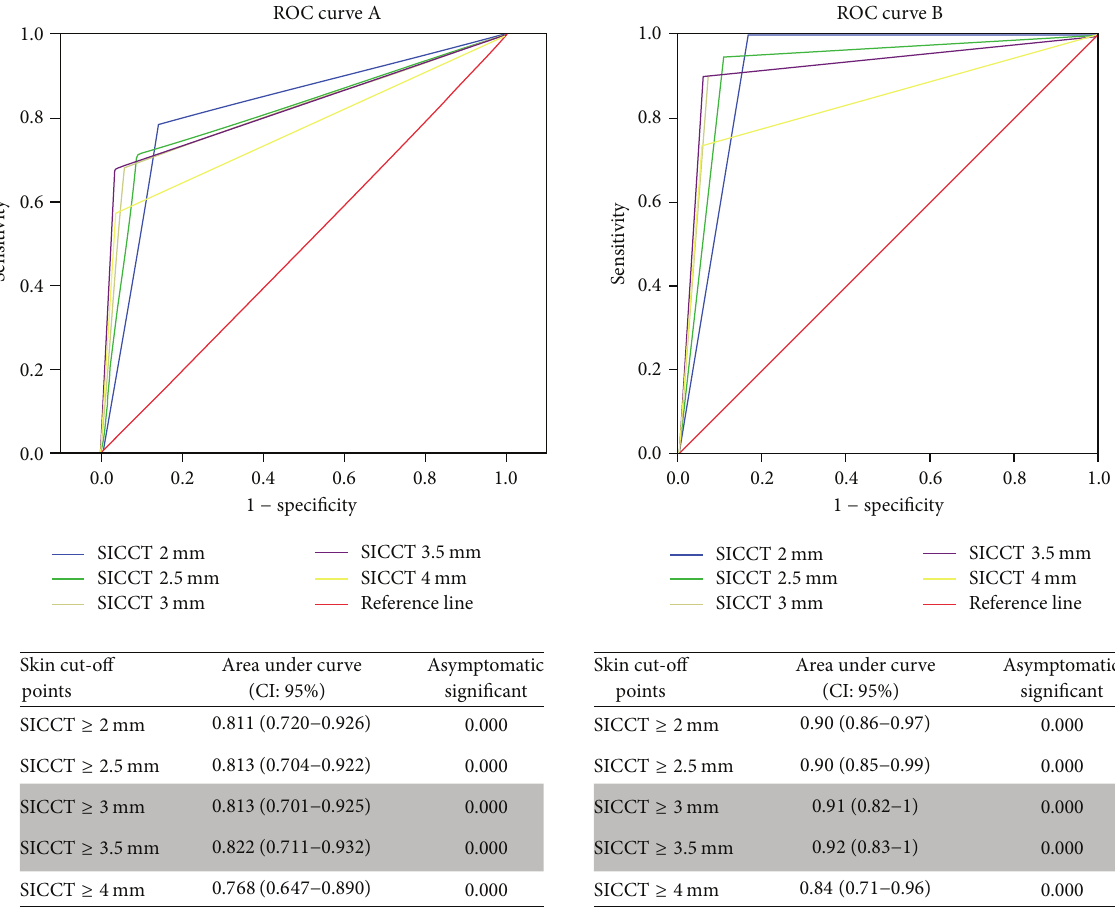
Figure 1: ROC ( Receiving Operating Characteristic ) analysis of the performances of SICCT to detect bovine Tb. Classification of the single intradermal comparative cervical tuberculin (SICCT) skin test cut-off point performance with detection of tuberculous lesions as reference test (curve A). Classification of the single intradermal comparative cervical tuberculin (SICCT) skin test cut-off point performance with detection of tuberculous lesions and acid fast bacilli as reference test (curve